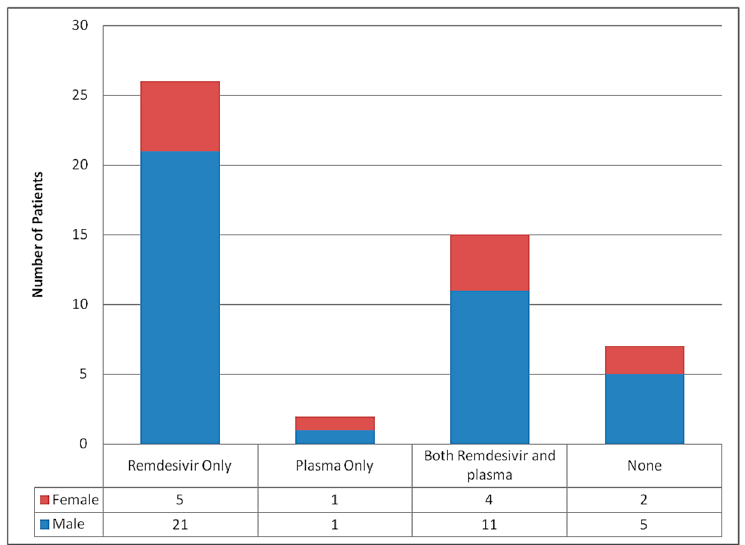
Figure 8. Treatment according to the gender of patients who died.